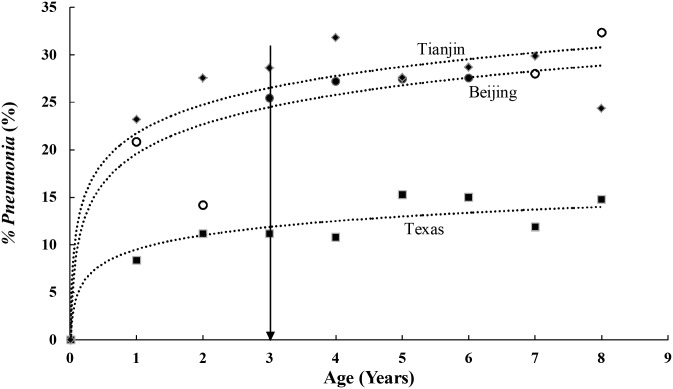
Lifetime-ever pneumonia (%Pneumonia) for each discrete age group from 1 to 8 years old in Beijing, Tianjin (China) and Texas (USA).Data for this figure is shown in S2 Table. The open circles for Beijing indicate small sample sizes.